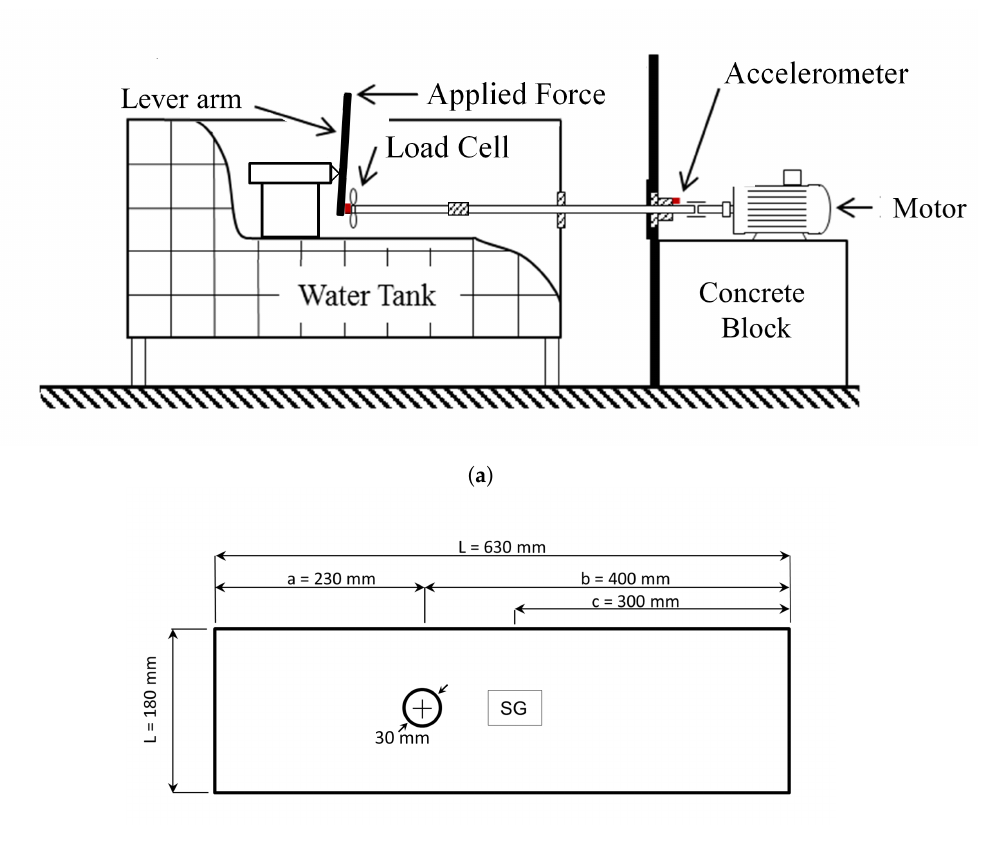
Figure 3. Schematic of: ( a ) the method of applying the force down the length of the shaft; ( b ) the supporting beam of the